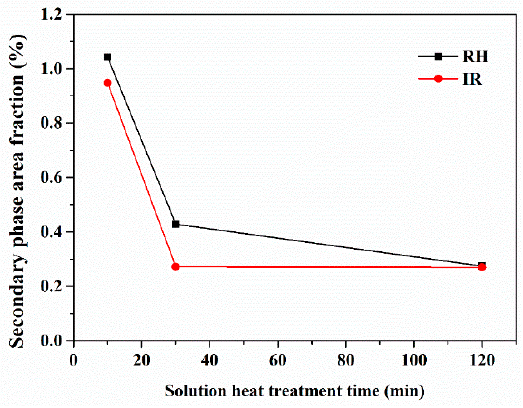
Figure 7. Area fractions of Al–Mg–Si phase and Al(FeMnCr)Si secondary phases.